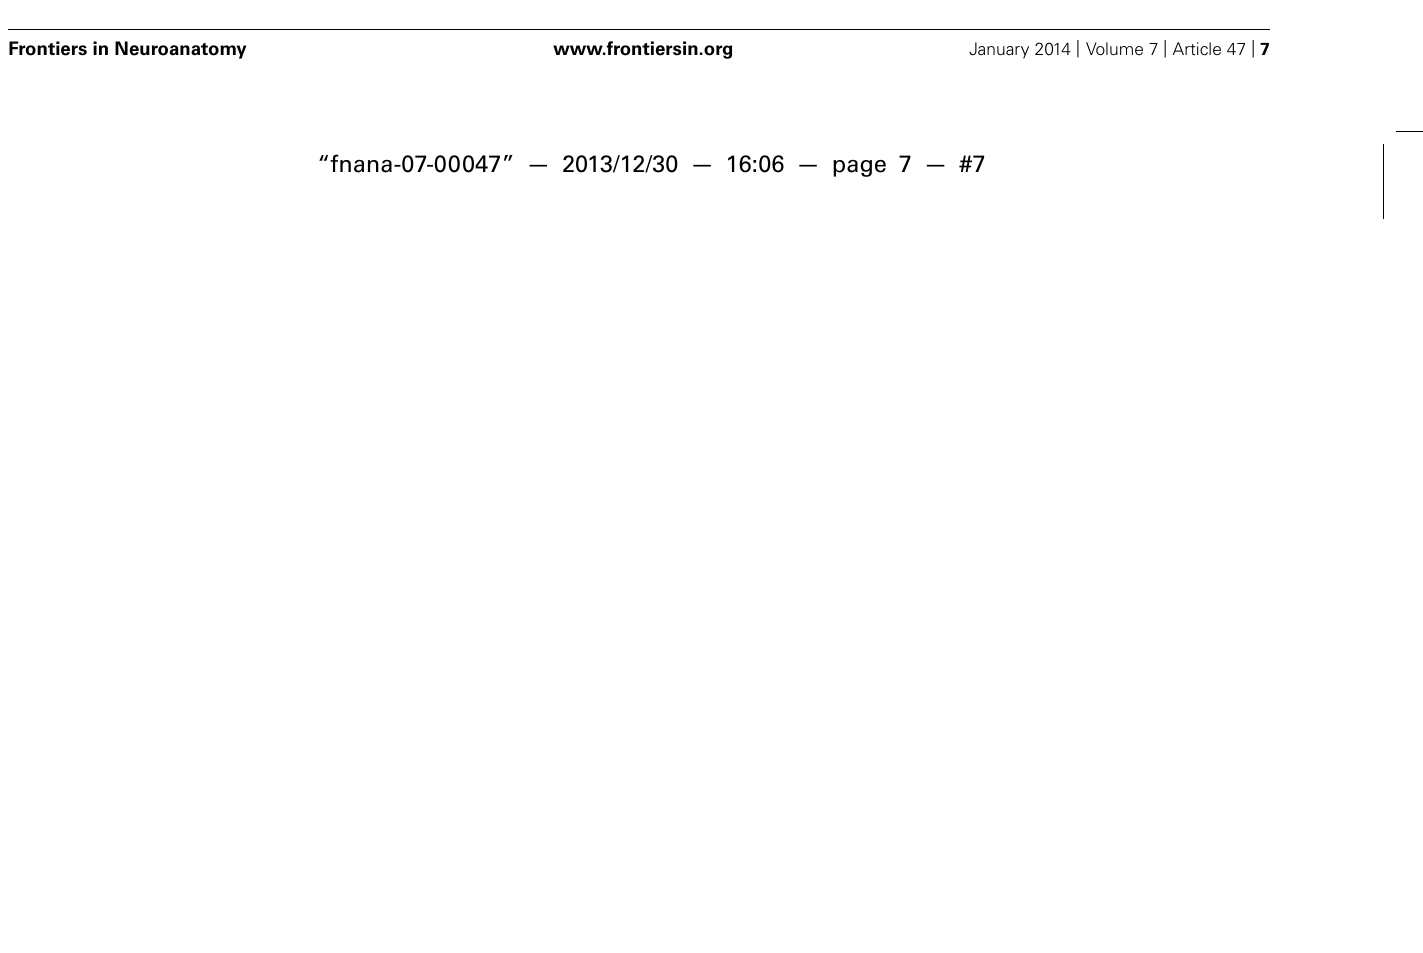
positive neurons (green) on 2 and 4 DPI. Middle, electroporated pyramidal neurons (red) in layer 2/3. Bottom, merged pictures of top two panels. The yellow cells in the bottom pictures were considered as starter cells. Scale bars = 100 μ